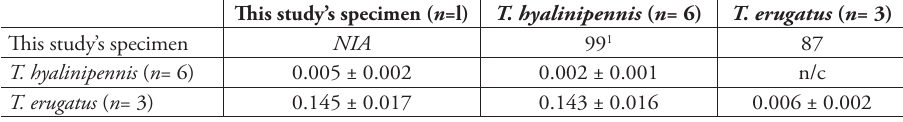
Table 3. Barcode mean pairwise genetic distances(± STD) between this study's specimen and expertly identified T. hyalinipennis and T. erugatus (under the diagonal), and within taxa (along the diagonal).